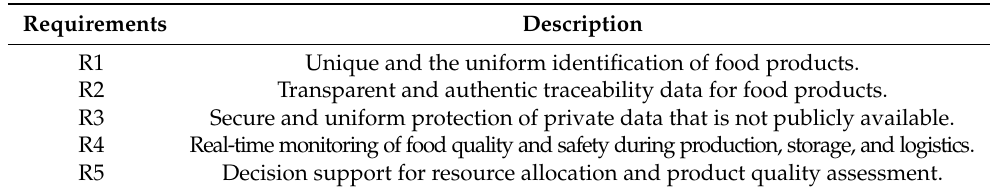
Table 1. Food safety requirements considered in this